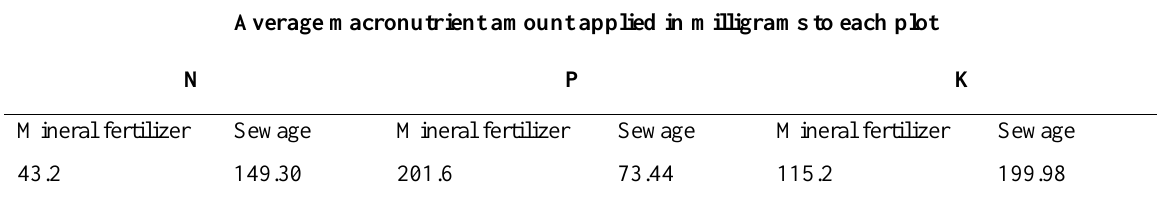
Table 6 Average macronutrient amount applied to plots by mineral fertilization and fertigation with WWTP-UFLA sewage during the monitoring